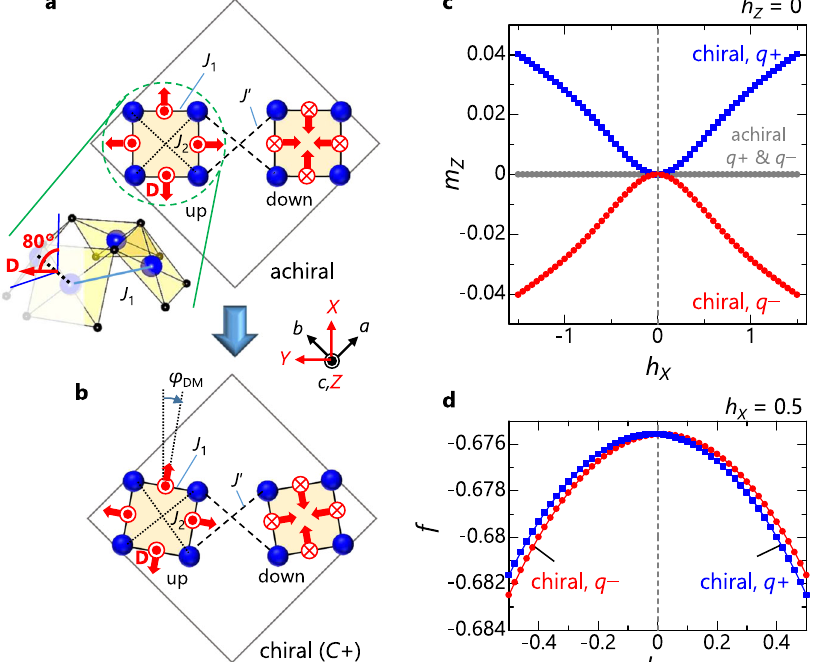
Fig. 6 Calculations based on the chiral spin-1/2 model. a , b Achiral ( a ) and chiral spin 1/2 model ( b ) and parameters setting. The red thick arrows represent the DM vector at the J 1 bond, D , which is considerably tilted from the Z axis by 80°. A staggered rotation of D by φ DM = 5° is introduced in the chiral spin-1/2 model. c Calculated results of the magnetization along the Z axis, m Z , as a function of magnetic fi eld ( h ) along the X axis, h X , in the absence of h along the Z axis ( h Z ). The gray symbols represent m Z in the case of φ DM = 0 for both q + and q − , which are zero within the numerical accuracy. The blue squares and the red circles denote m Z for q + and q − , respectively, in the case of φ DM = 5°. d h Z dependence of the free energy f at h X = 0.5 in the case of φ DM =